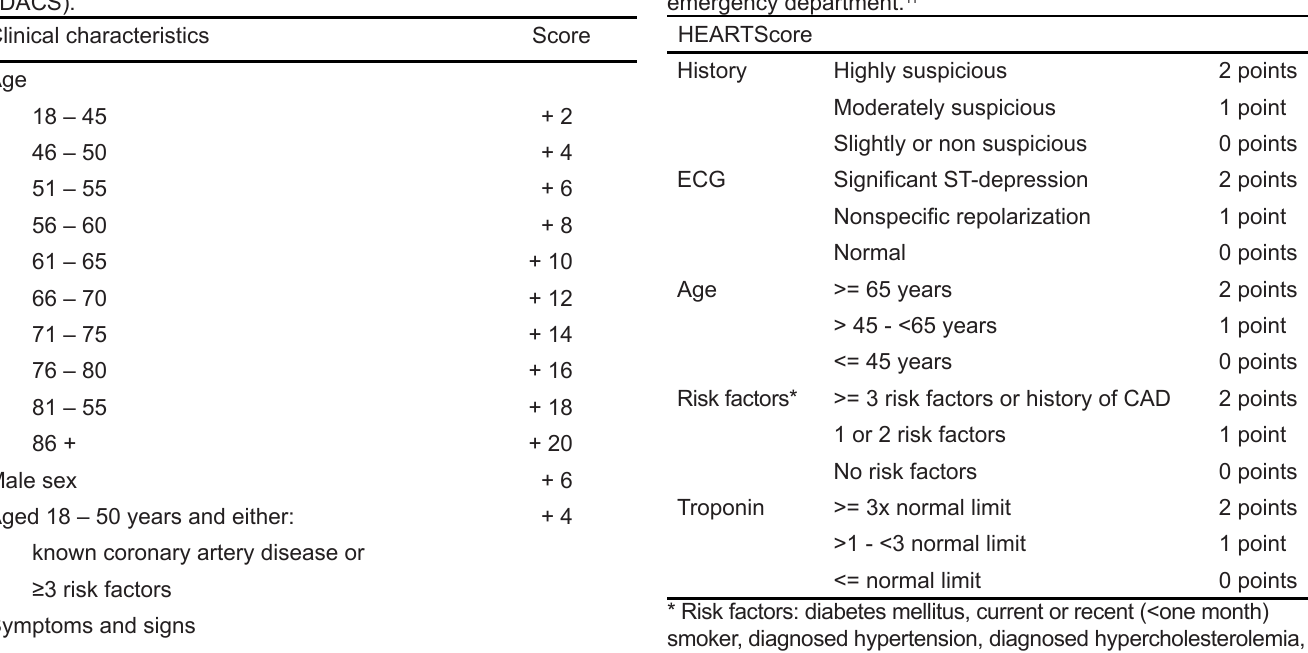
Table 4. The HEARTScore for chest pain patients in